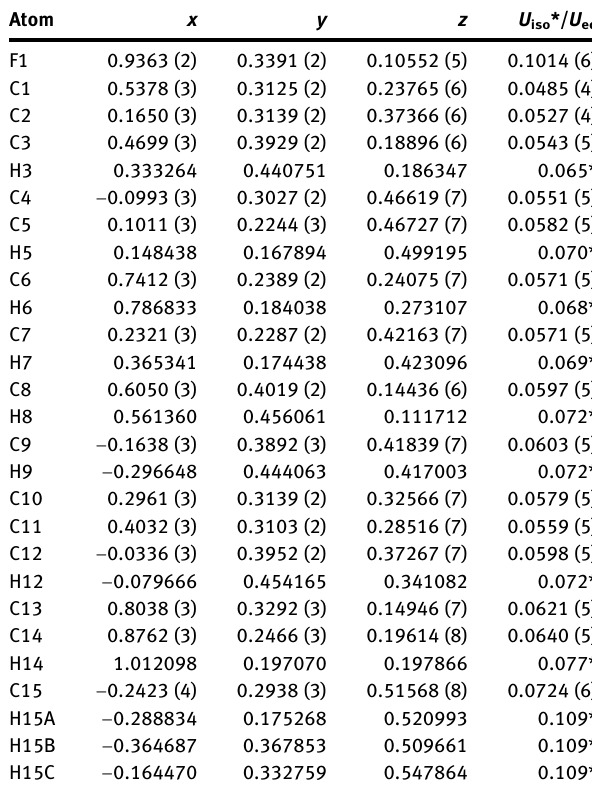
Table  : Fractional atomic coordinates and isotropic or equivalent isotropic displacement parameters (Å 